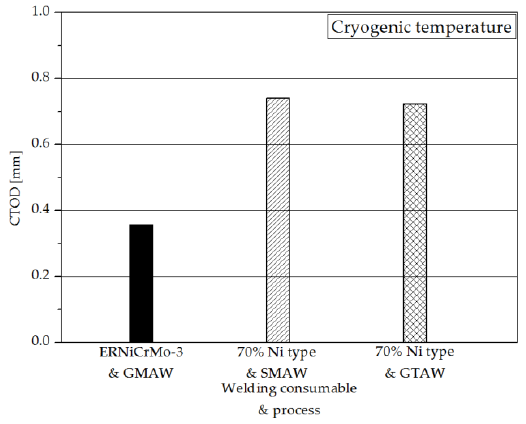
Figure 10. Comparison of the CTOD values of the HAZ for other welding process [17].